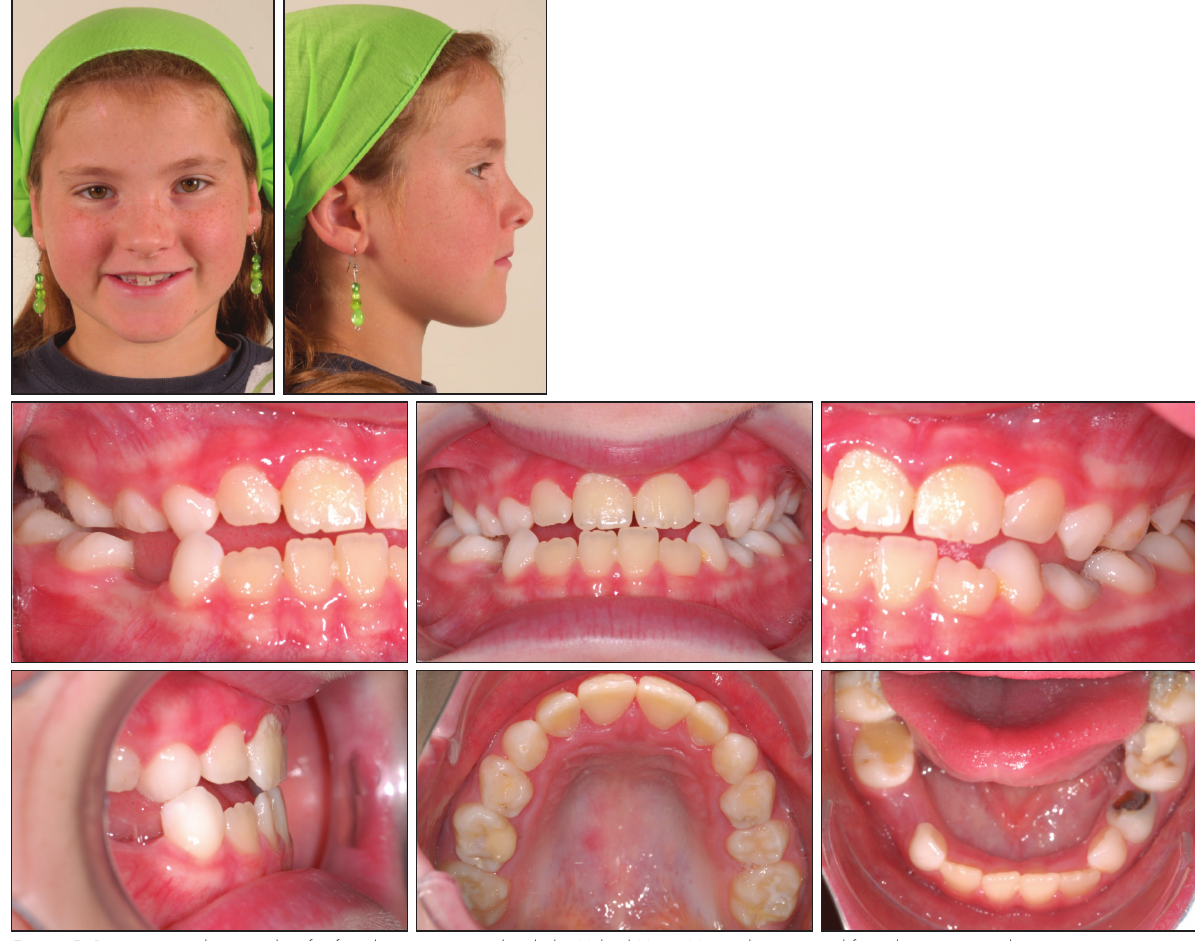
Figure 5. Pretreatment photographs of a female patient treated with the Hybrid Hyrax-Mentoplate protocol from the present